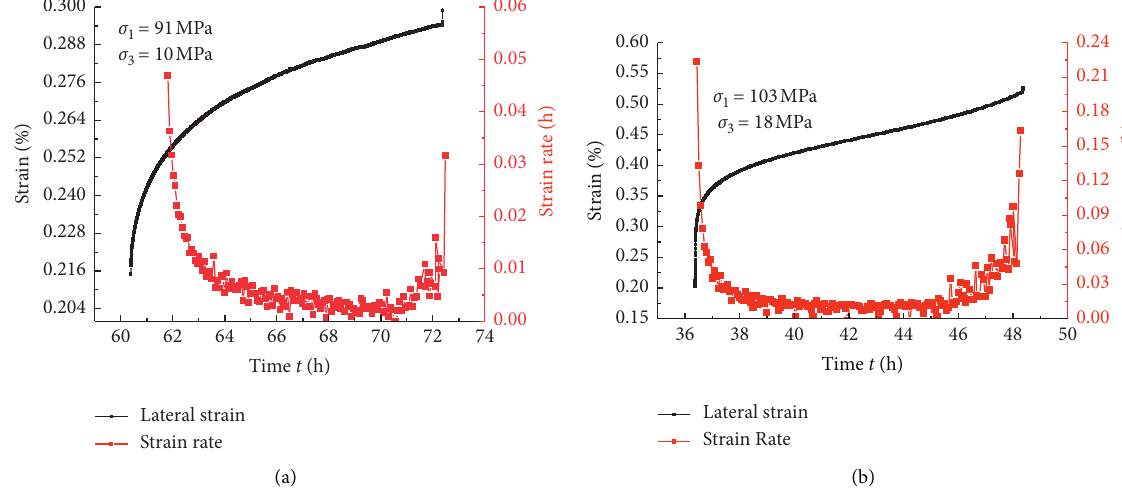
Figure 13: Lateral strain and creep rate of fracture confining pressure. (a) Scheme 1. (b) Scheme 2.